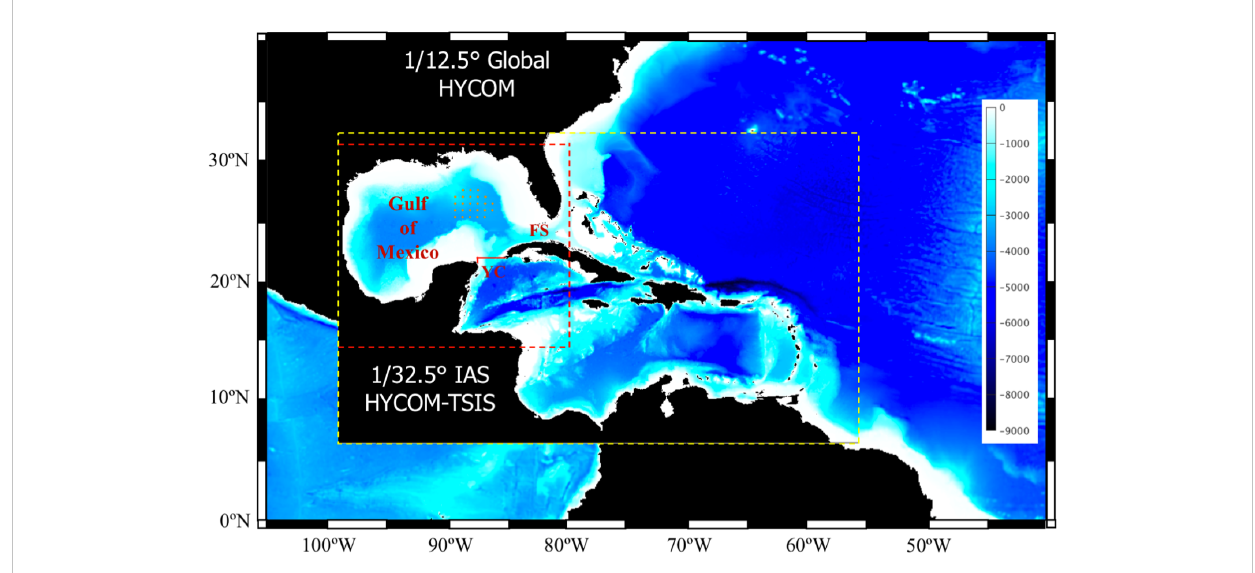
FIGURE 1 Bathymetry map of the computational domain of the 1/32.5° IAS HYCOM-TSIS forecast modeling system (yellow dashed box) nested within the outer model. In OSEs, the domain is nested into the 1/12.5° Global HYCOM reanalysis (GOFS3.0). In OSSEs, the domain is nested into the 1/12° GLORYS reanalysis. The red dashed lines delineate the outer boundaries of the NEMO domain providing the nature run fi elds. The orange bullets in the eastern GoM indicate PIES locations. The Yucatan Channel (YC) and the Florida Straits (FS) are indicated. The red line designates location of the vertical section of the mean along-channel velocities shown in Figure